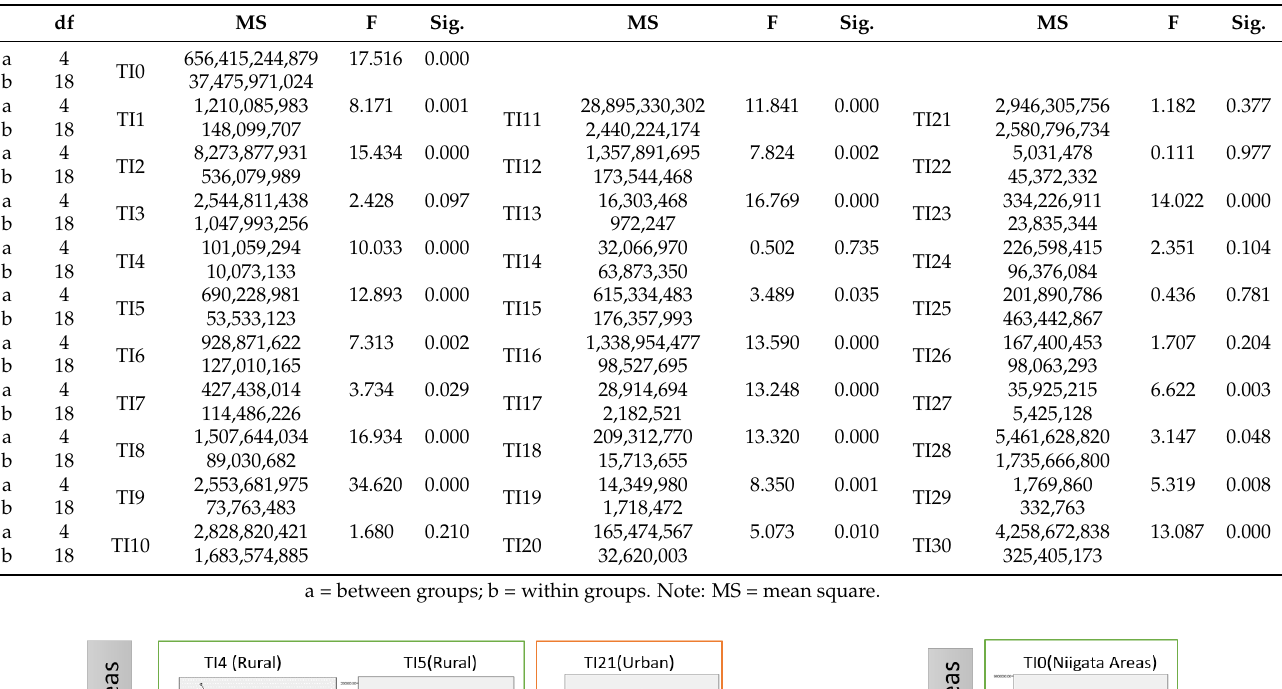
Table 4. ANOVA (Total Income).